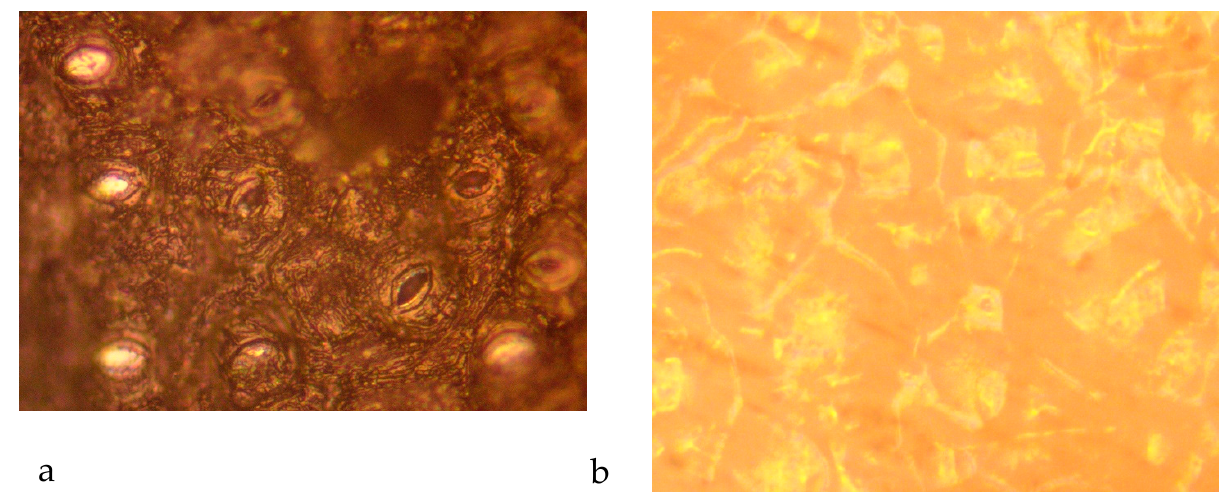
a b Figure 14. Blueberry leaves (Bluecrop) recovered from partially desalinated seawater containing Fe@blue crop polymer. ( a ), View of the stomata showing NaCl in the stomatal cavities (white) and NaCl present under the cuticle, reflected light; Field of view = 1.1 mm; ( b ), view of the leaf showing NaCl precipitated within the leaf structure under the cuticle; reflected light, field of view = 0.25 mm.